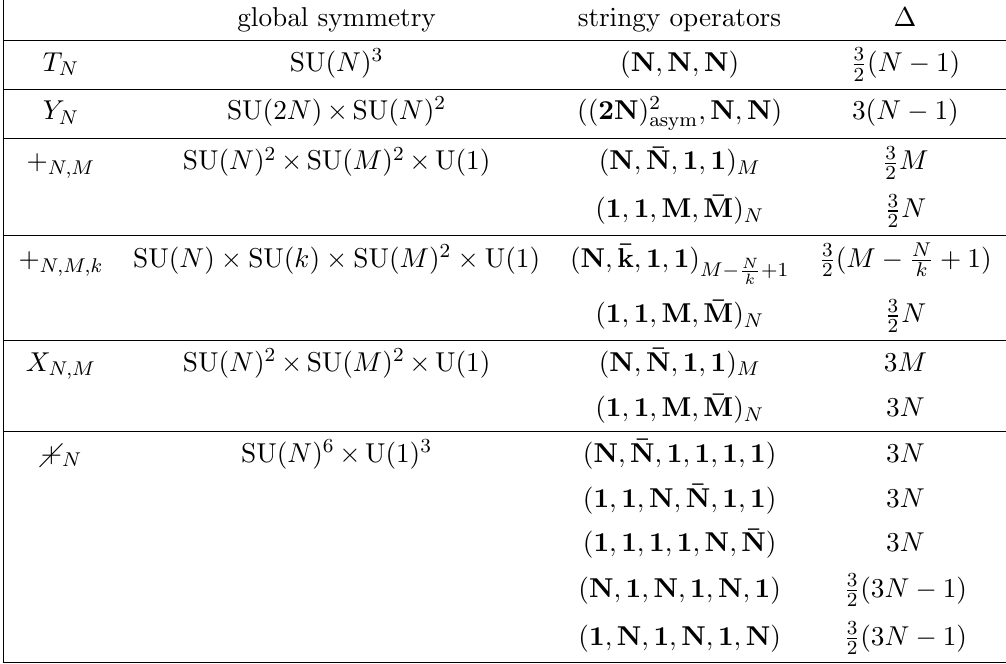
Table 1. The theories discussed in section 2, with their global symmetries, stringy operators and the scaling dimensions inferred from (cid:12)eld theory considerations. The proposed supergravity duals pre- cisely reproduce the stringy operators and their scaling dimensions in the appropriate large- N